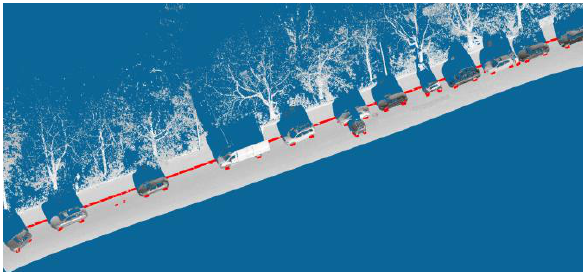
Figure 7. Extracted potential curbstone positions including outlier shown mostly as car wheels.